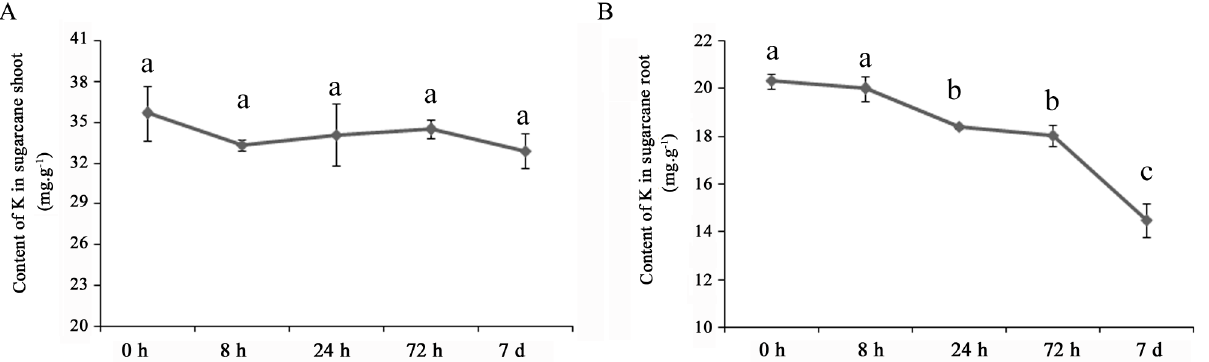
Fig 1. K concentration in sugarcane shoots and roots under low-K stress. The K concentration of sugarcane was measured after 0 h, 8 h, 24 h, 72 h and 7 d of low-K stress. A) The K concentration in shoots at 0 h, 8 h, 24 h,72 h and 7d; B) The K concentration in roots at 0 h, 8 h, 24 h,72 h and 7d. The different lowercase letters above the error bar (standard error) indicate significant differences (P < 0.05) in the K concentration between 0 h and the other four time points (8 h, 24 h, 72 h and 7d); n =